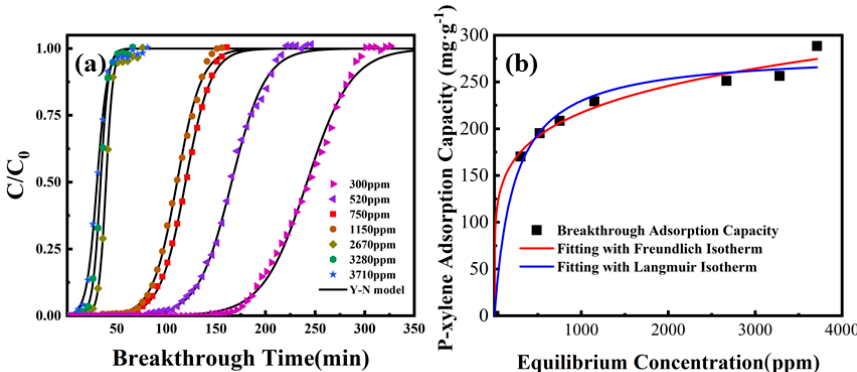
Figure 10. ( a ) Breakthrough curves at different inlet concentration ( b ) Fitted isothermal adsorption curve. Figure10. ( a )Breakthroughcurvesatdi ff erentinletconcentration( b )Fittedisothermaladsorptioncurve.